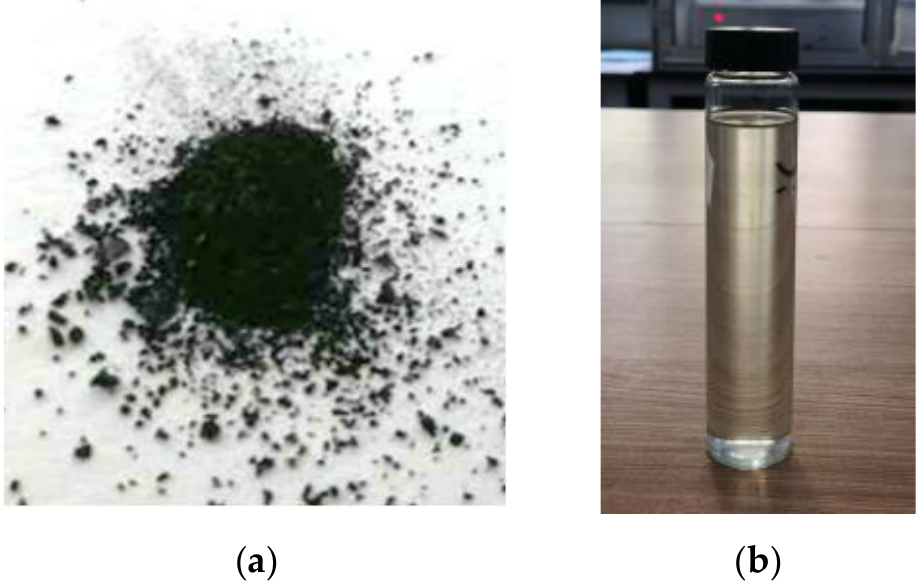
Figure 2. Macroscopic schematic diagram of nanoadditives. ( a ) Nanoemulsion; ( b ) 2D nano black- card.